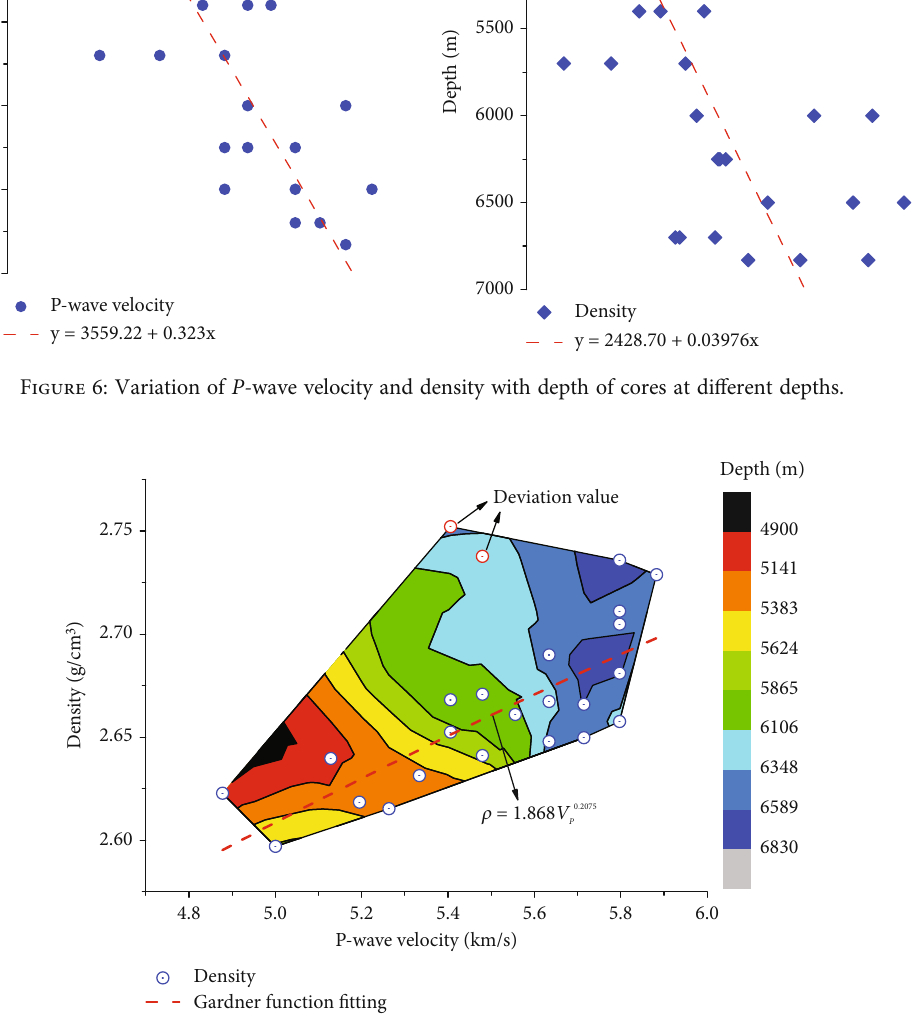
Figure 7: Relationship between P -wave velocity and density of cores at di ff erent